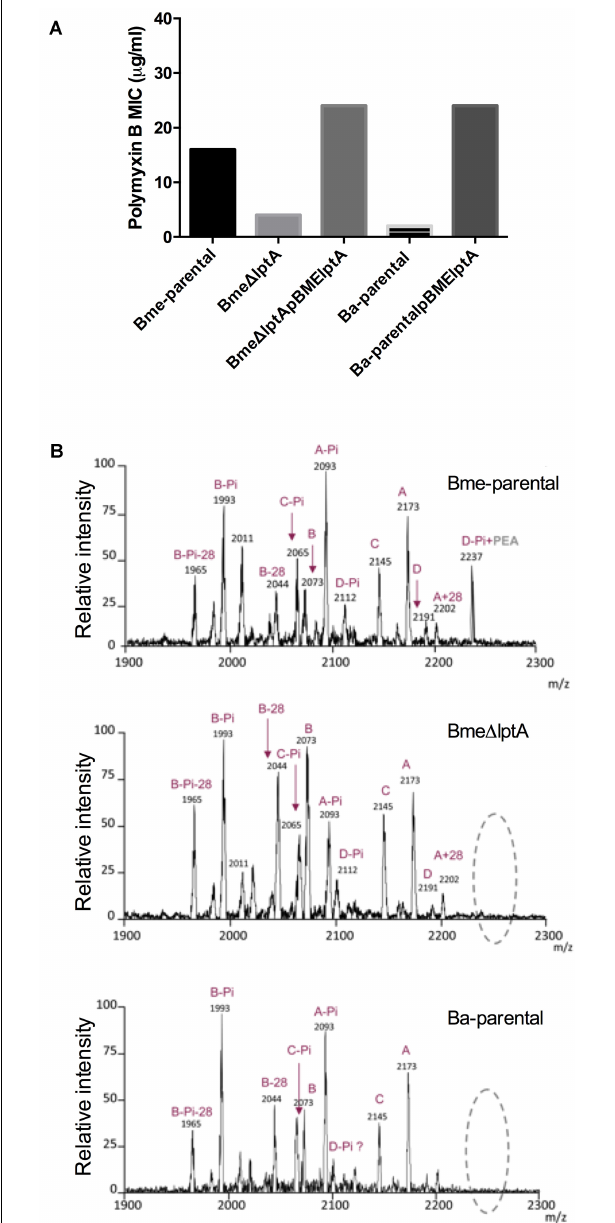
FIGURE 2 | The Brucella lptA orthologs are involved in polymyxin B resistance and code for a phosphate-ethanolamine transferase acting on lipid A. (A) Polymyxin B sensitivity of B. melitensis wild-type (Bme-parental), B. melitensis non-polar lptA mutant (Bme lptA ), the cognate complemented mutant (Bme (cid:49) lptA pBME lptA ), B. abortus wild-type (Ba-parental), and B. abortus wild-type carrying a plasmid with the B. melitensis lptA gene (Ba-parentalpBME lptA ) (the results are representative of three independent experiments). (B) MALDI-TOF analysis of the lipid A of Bme-parental, Bme (cid:49) lptA , and